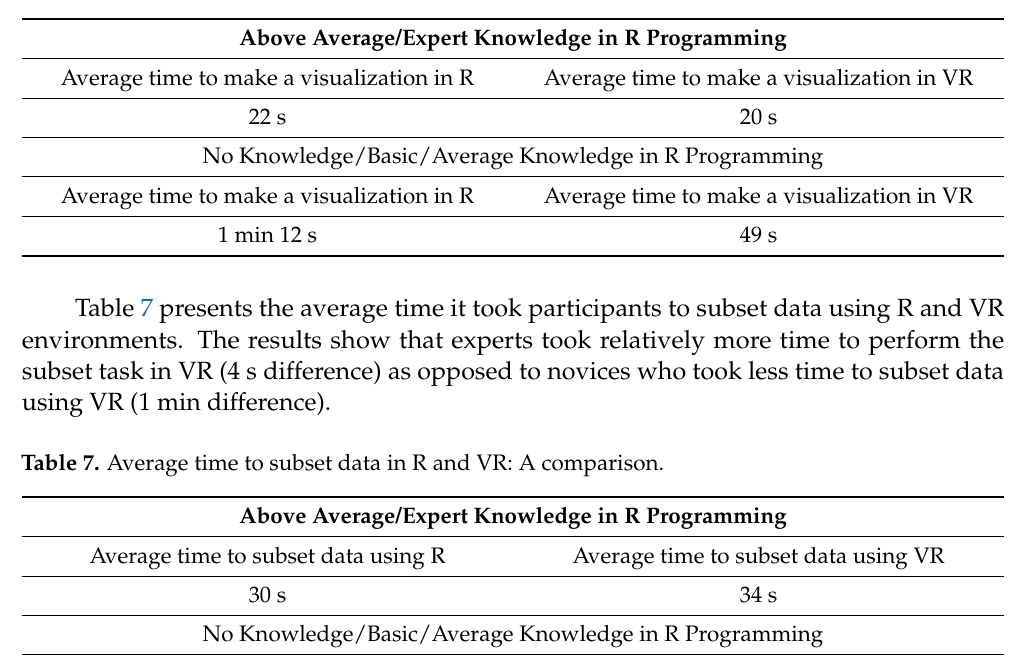
Table 6. Average time to generate a visualization in R and VR: A comparison.